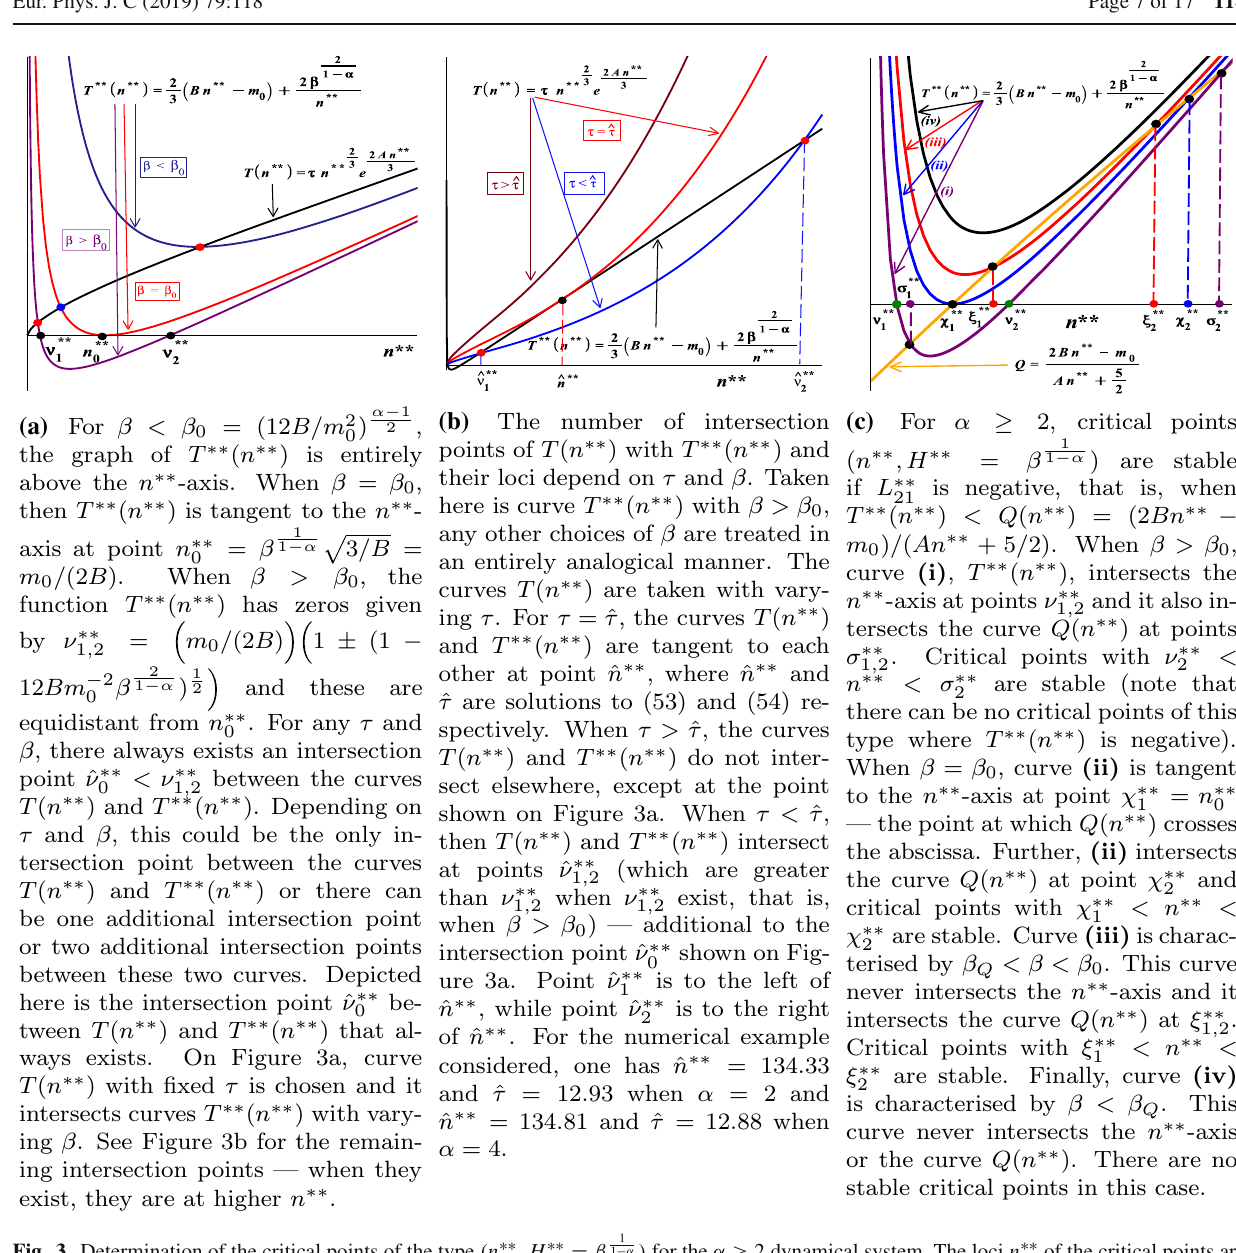
Fig. 3 Determination of the critical points of the type ( n ∗∗ , H ∗∗ = β 1 1 − α ) for the α ≥ 2 dynamical system. The loci n ∗∗ of the critical points are the solutions of T ∗∗ ( n ∗∗ ) = T ( n ∗∗ ) – a and b . c Shows where stable critical points of the type ( n ∗∗ , H ∗∗ = β 1 1 − α ) can be